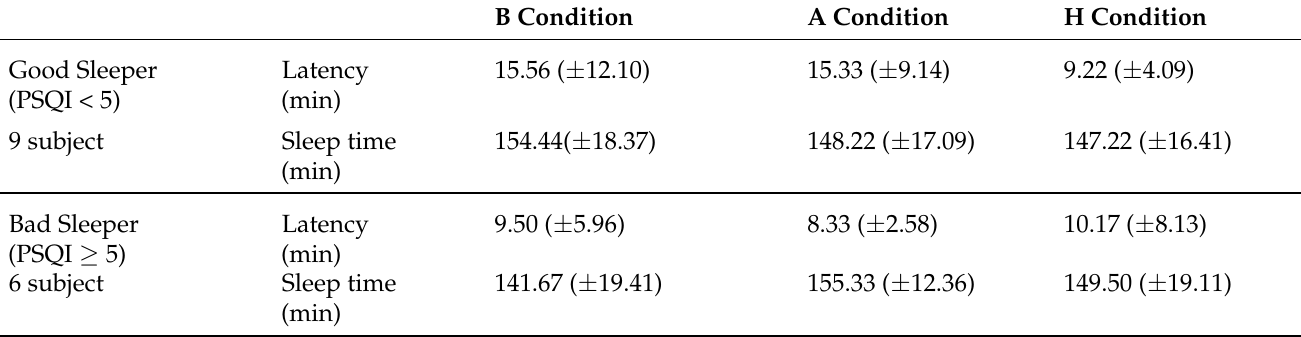
Table 6. Comparison of the reported self-reported sleep quality between two sleep type groups ‘Good